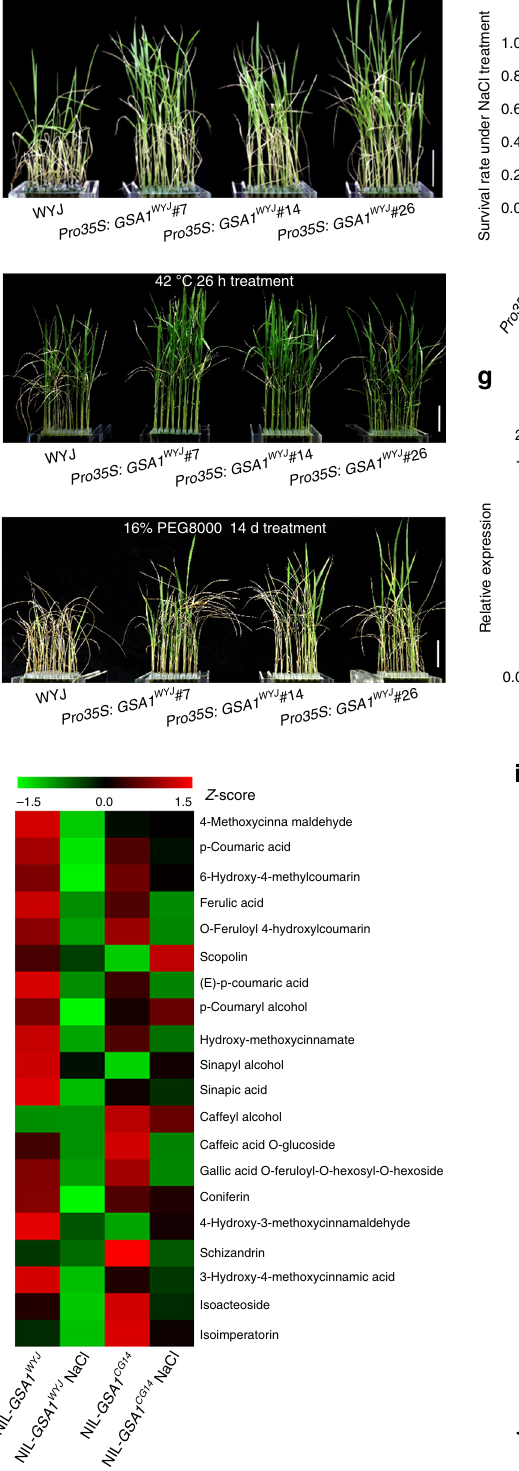
Discussion Grain size determines grain weight, which is an essential agro- nomic trait affecting rice yield. A number of major QTLs reg- ulating grain size have been identi fi ed and found to be involved in the ubiquitin-proteasome pathway, G-protein signaling, mitogen- activated protein kinase signaling, phytohormones signaling,